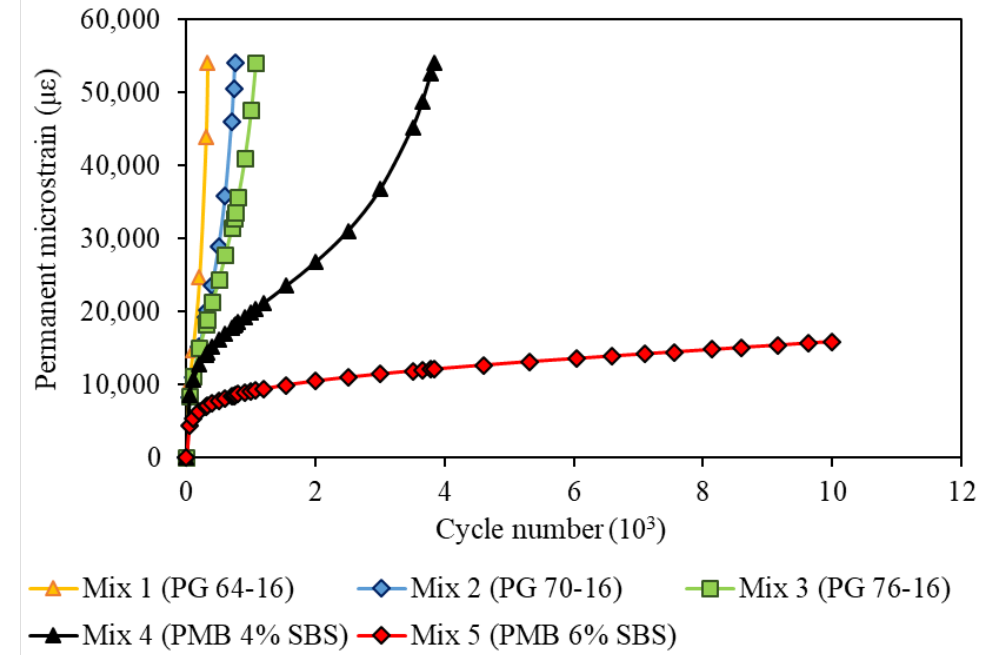
Figure 6. Representative permanent strain curves of the five mixtures tested in Dynamic Creep test.